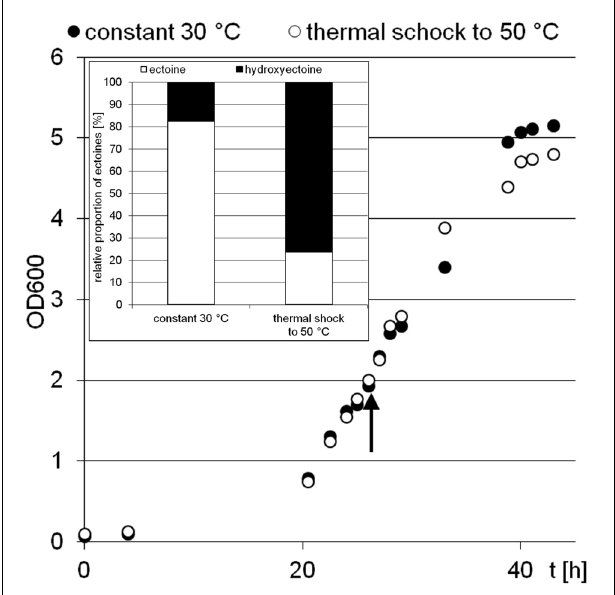
FIGURE 2 | Influence of temperature and salinity on the relative proportion of hydroxyectoine in H. elongata . Error bars represents lowest and highest value of duplicate measurements for both salinities at 30 ◦ C and for 15% NaCl at 45 ◦ C; all others represent standard deviations of three replicates (in the case of 15% NaCl, upshock) or at least four replicates.